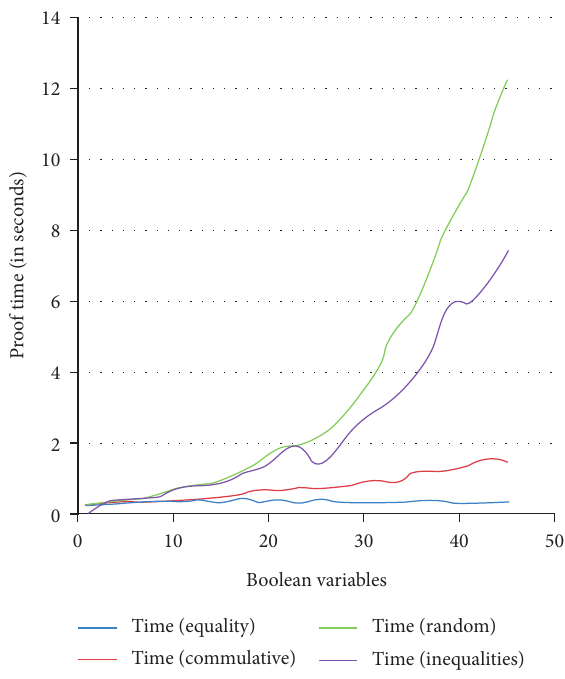
Figure 14: Performance evaluation of